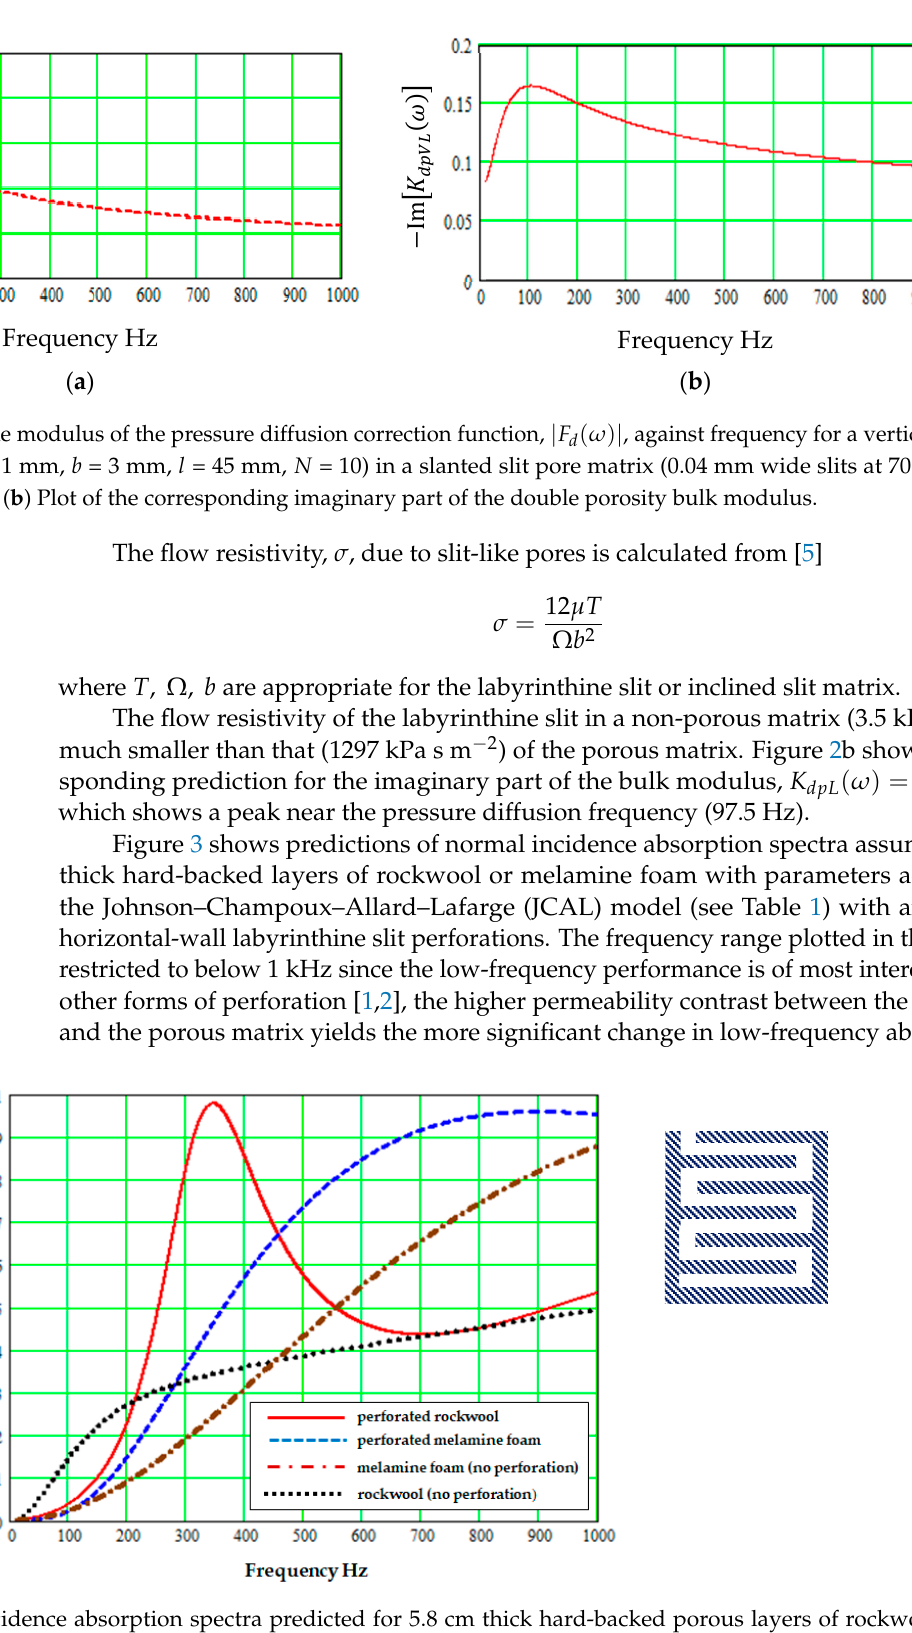
Figure 3. Normal incidence absorption spectra predicted for 5.8 cm thick hard-backed porous layers of rockwool and melamine foam described by the JCAL parameters listed in Table 1 with horizontal-wall labyrinthine slit perforations ( w = 5 mm, b = 5.5 mm, l = 40 mm, N = 5 as shown on the right). Also shown (dash dot lines) are predictions for these materials without perforation.